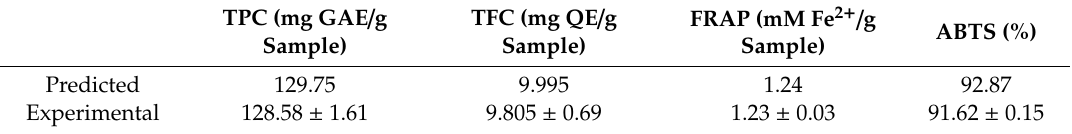
Table 2. Predicted and Experimental Values for Responses of TPC, TFC, FRAP, and ABTS.